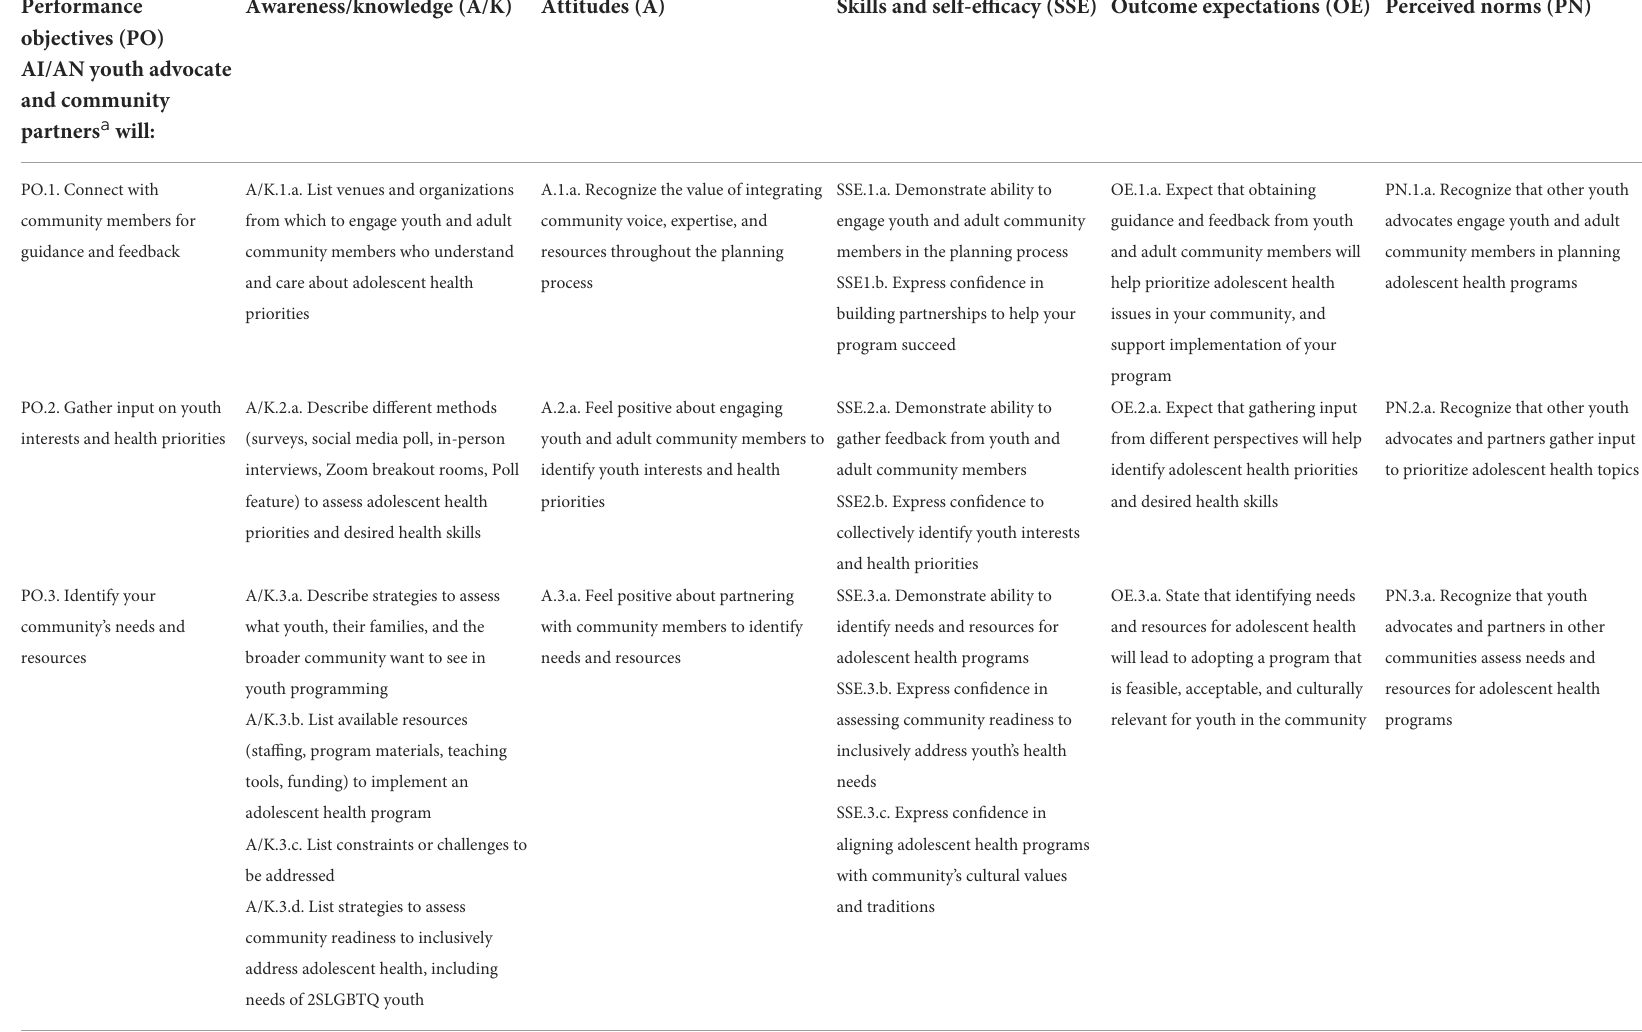
TABLE 3 Implementation Mapping Task 2: Example matrix of change objectives for adoption outcome, “GATHER community members to get guidance and feedback.”